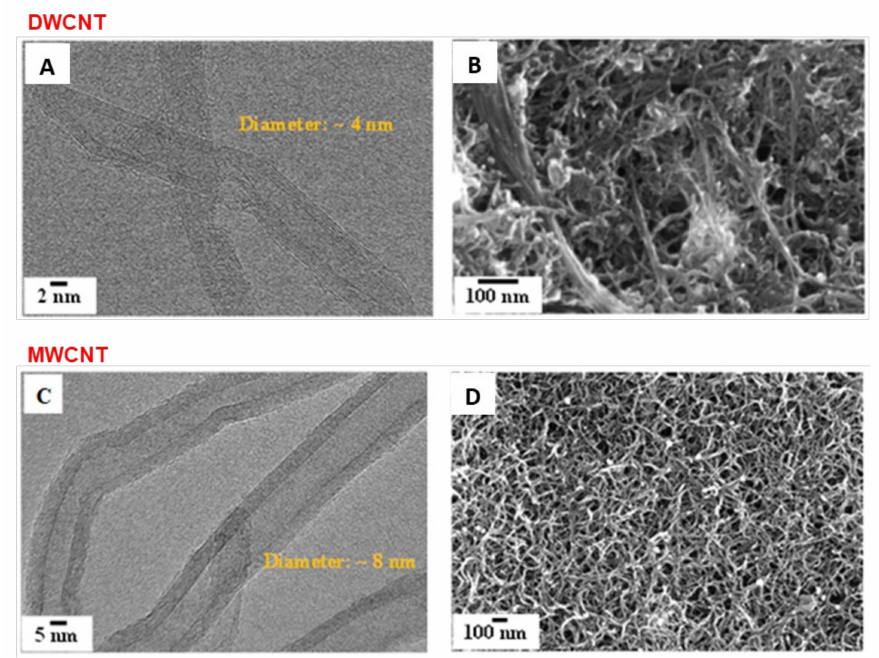
Figure 2. HRTEM images of the DWCNTs ( A ) MWCNTs ( C ) and FEG-SEM images of DWCNT ( B ), MWCNT ( D ) based thin films deposited on the gold patterned quartz